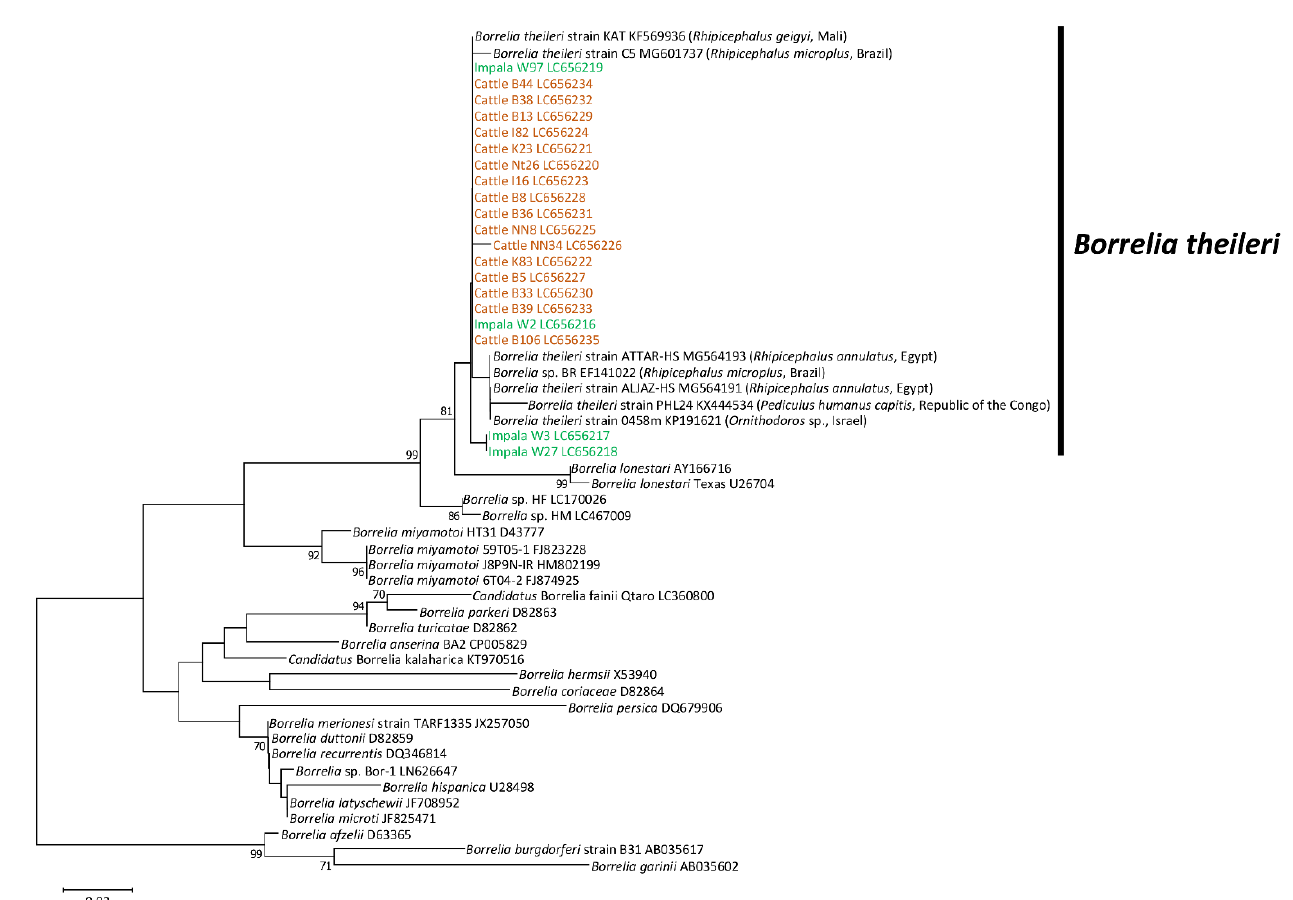
Figure 1. Phylogenetic inference of Borrelia spp. based on partial sequence of flaB . The accession numbers for nucleotide sequences are shown after the species names. The analysis was performed using the neighbor-joining method. Bootstrap values > 70% based on 1000 replications are presented on the interior branch nodes.